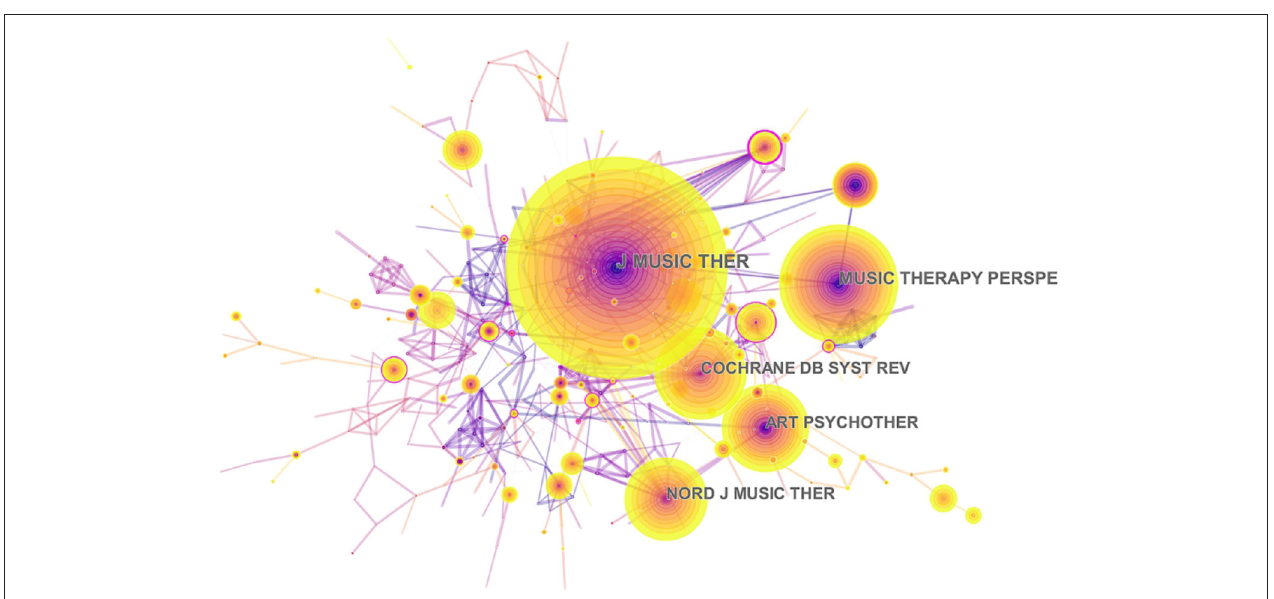
FIGURE 6 | Network map of co-citation journals engaged in music therapy from 2000 to 2019. Journal of Music Therapy, Arts in Psychotherapy, Nordic Journal of Music Therapy, Music Therapy Perspectives, Cochrane Database of Systematic Reviews. In this map, the node represents a journal, and the link represents the co-citation frequency between two journals. A larger node represents more publications in the journal. A thicker purple circle represents greater influence in this field.